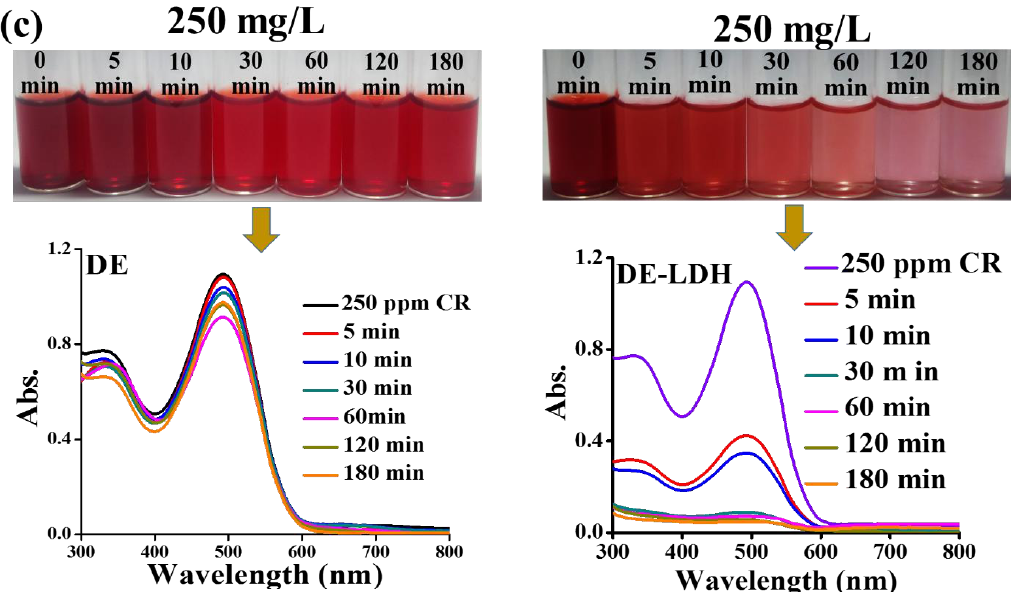
Figure 6. Supernatant of CR before and after adsorption on DE and DE-LDH with respect to contact time and corresponding UV-visible spectra ( a ) 50 mg / L ( b ) 100 mg / L and ( c ) 250 mg / L (adsorbent dosage: 40 mg, pH: 7, volume: 25 mL, temperature: 30 °C). Appl. Sci. 2020 , 10 , x FOR PEER REVIEW